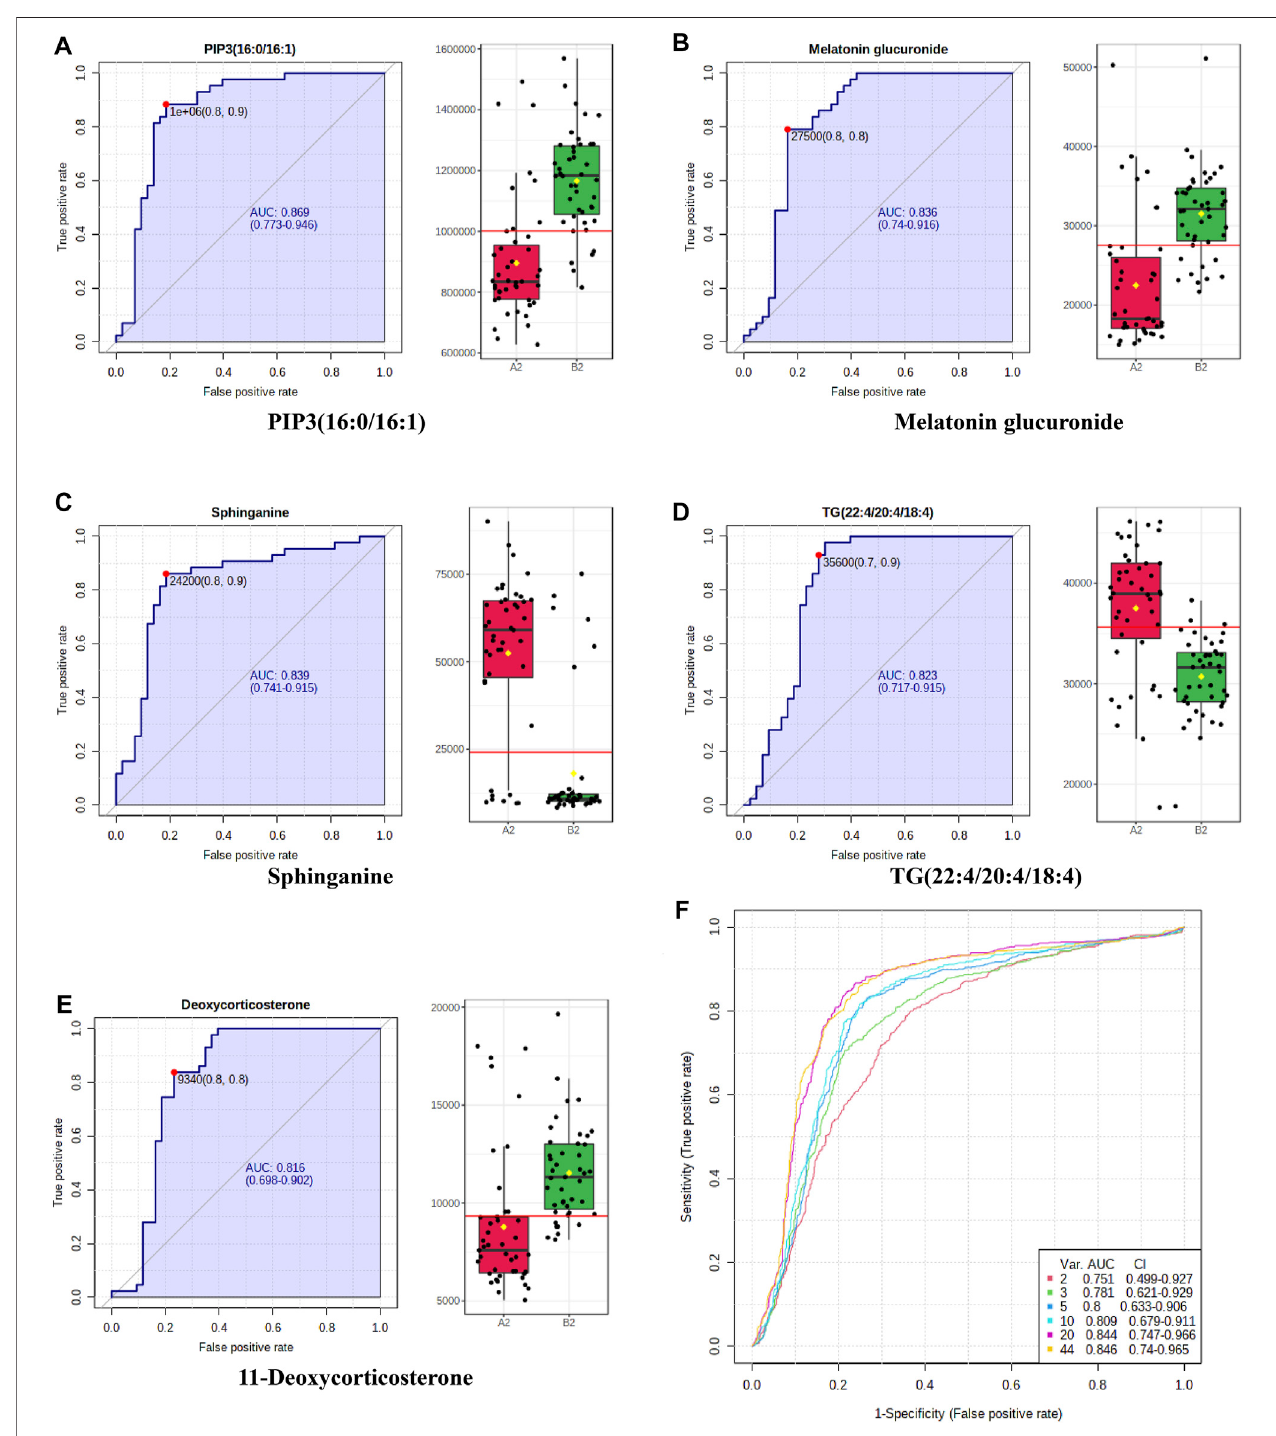
FIGURE 9 | Representative ROC curve plots of potential biomarkers. (A – E) Representative ROC curves and AUC values of potential biomarkers with high- performance prediction. Box plots in green ( ) represent ZYP group while in red ( ) represent placebo group. (F) Multivariate exploratory ROC analysis overview.